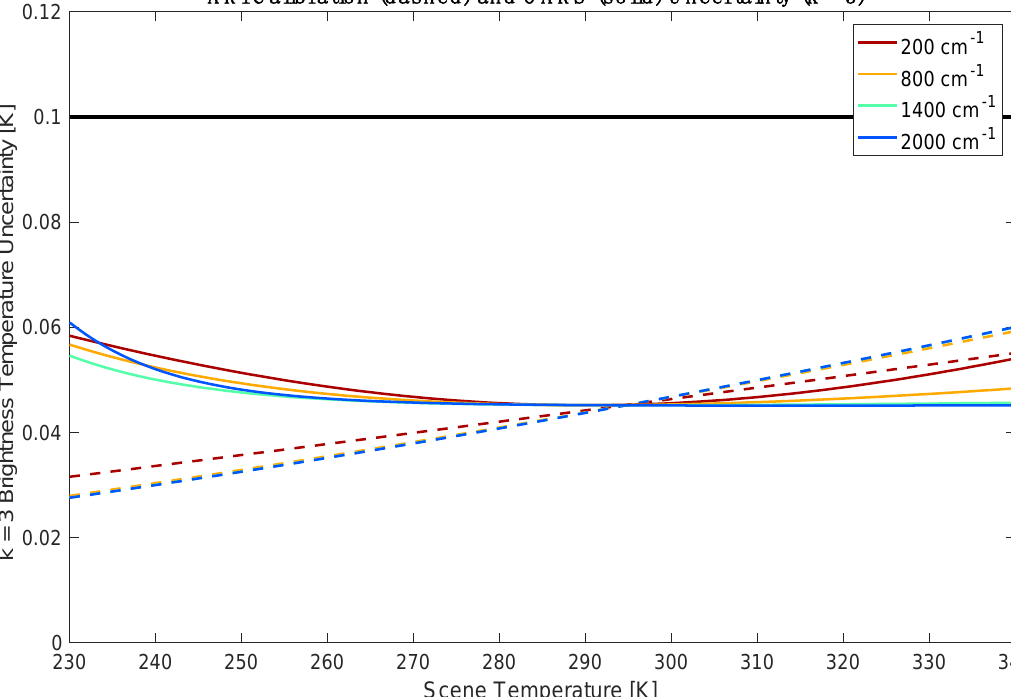
Figure 6. Predicted on-orbit combined radiometric calibration and verification uncertainty (k = 3). 4.3.2. Predicted Uncertainty: Laboratory Testing For cost compatibility with the scope of the NASA Instrument Incubator Program funding for the ARI prototype development and demonstration, testing during the IIP phase was conducted in a